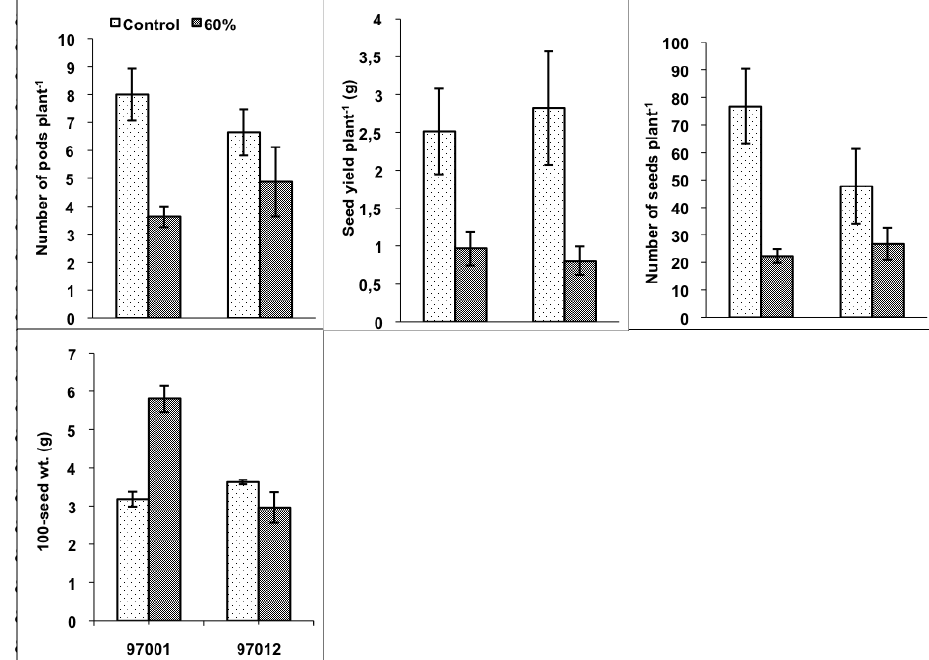
Fig. 4: Leaf and root N and yield attributes of mungbean [ Vigna radiata (L.) Wilczek] when 30 day old plants were subjected to drought stress (Mean ± S.E.; n =